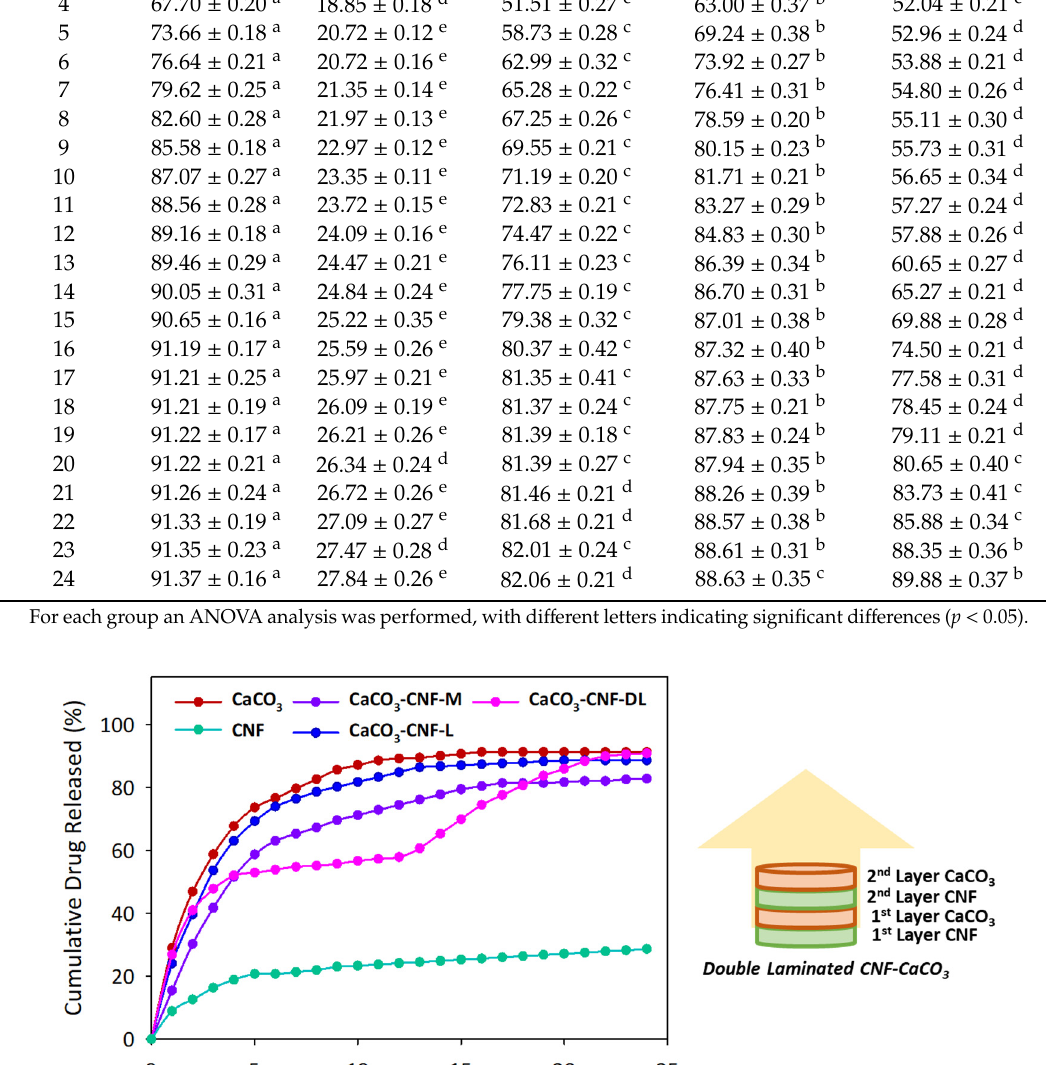
Figure 6. Kinetics release of 6 ppm of 5-FU using different 3D printed films of CNF, CaCO 3 , CNF